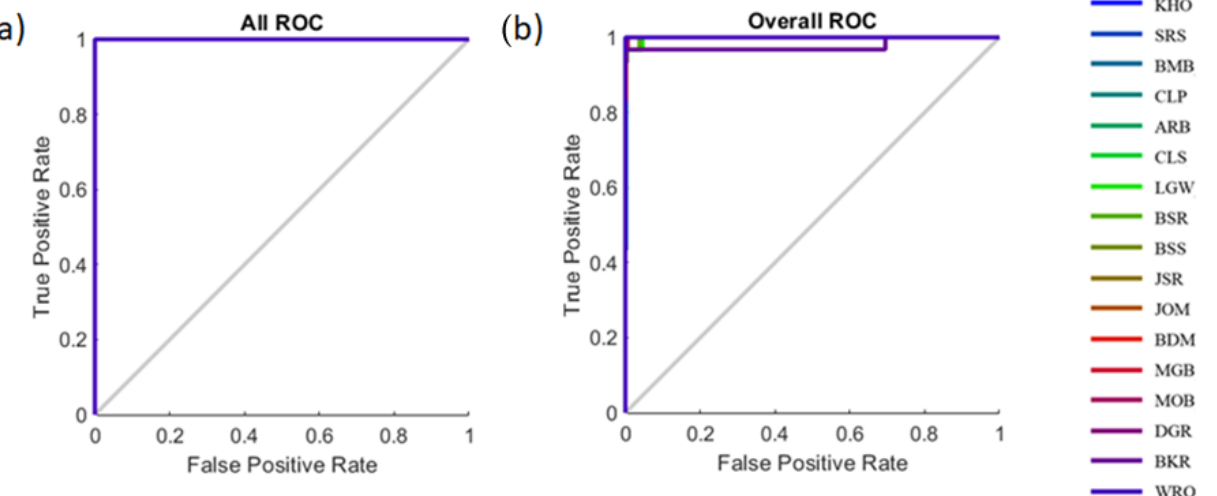
Figure 4. The receiver operating characteristic (ROC) curves showing the true-positive versus false- positive rates for ( a ) Model 1 and ( b ) Model 2 to classify 17 types of rice samples.